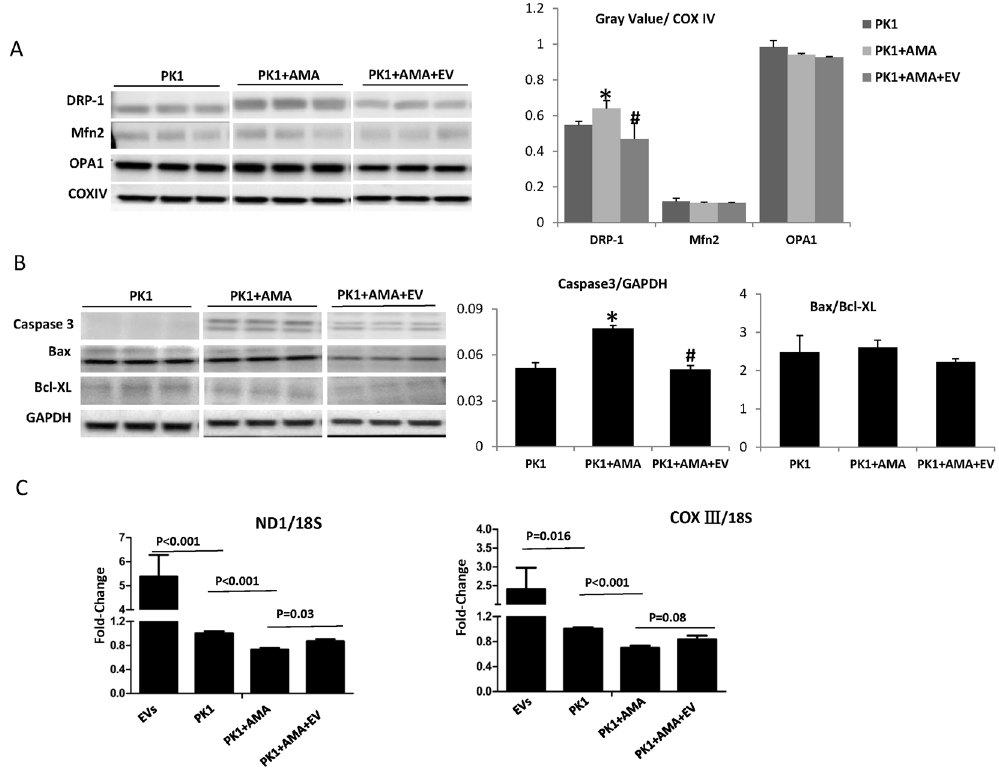
Figure 5. Mitochondrial regulatory proteins and mitochondrial DNAs. ( A ) After Antimycin A (AMA) exposure, the expression of dynamin-related protein1 (DRP1) in PK1 mitochondria increased significantly, but was attenuated by STC-like cells-EV. No significant changes were observed in fusion-related proteins Mitofusin 2 (Mfn2) and Optic Atrophy-1 (OPA1). ( B ) Pro-apoptosis caspase3 evaluated after AMA treatment in PK1, and EV down-regulated its expression. There was no change of Bax/Bcl-XL ratio. ( C ) ND1 and COXIII DNAs decreased significantly after AMA treatment in PK1. STC-like cells-EV contained mtDNAs and improved its expression in injured PK1 ( * P < 0.05 vs PK1, # P < 0.05 vs PK1 + AMA). The representative Western blots were cropped from the different parts of the same gel, and the full-length blots can be found in Supplementary info